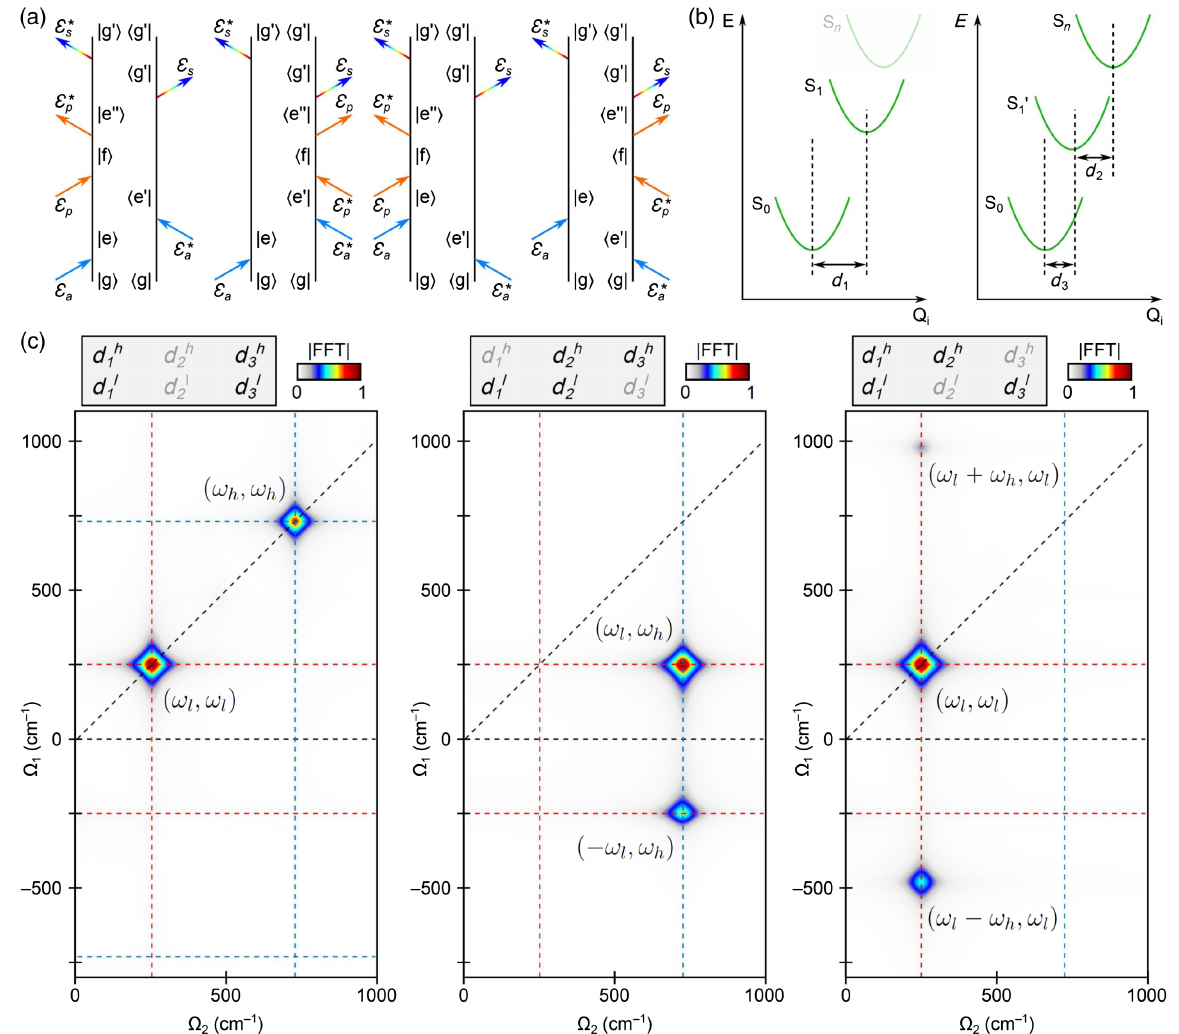
FIG. 4. Theoretical interpretation of 2D-ISRS signals in the harmonic model. (a) Double-sided Feynman diagrams describing the contributions to the signal. (b) Different energy landscapes along the vibrational coordinate Q and Raman and probe pair (right panel). In the harmonic model, even if three electronic energy potentials are involved, three different displacements among them have to be considered, since d 1 can be different from d 3 , due to the relaxation of the molecule out of the FC region. (c) Simulation of the linearly displaced harmonic model for a two-mode system ω three different choices of the displacement set, in which two of the six parameters are set equal to zero. For each panel, the two nondisplaced coordinates are indicated in gray by the color scheme on top. The left panel shows diagonal peaks obtained for d h 2 , d l 2 ¼ 0 and the other parameters different from zero; the central panel shows two cross peaks at Ω 1 ¼ (cid:2) ω d h 1 and d l 3 ; in the right panel, the only vanishing displacements are d l 2 and d h 3 , which lead to a diagonal peak at ω (cid:2) ω bands at Ω 1 ¼ ω and Ω 2 ¼ ω . Red (blue) horizontal and vertical lines highlight the ω h l l